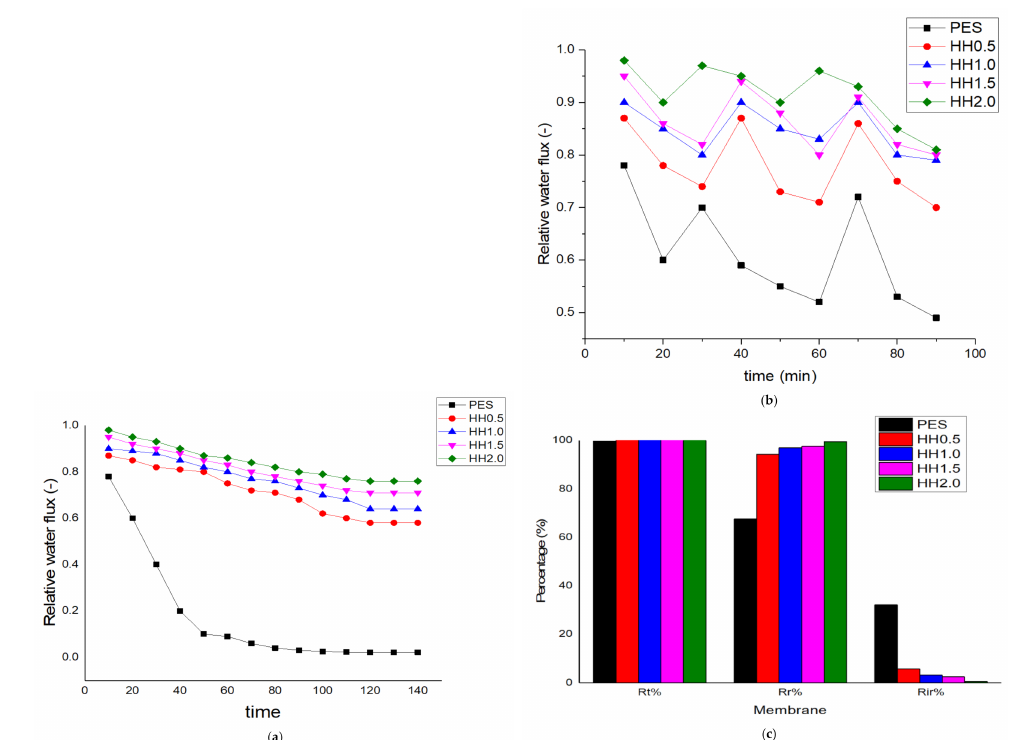
Figure 4. Time dependence of water permeation flux variations during membrane filtration of ( a ) bovine serum albumin (BSA) solution, ( b ) after washing with de-ionized water and ( c ) summary of corresponding fouling reversibility property.